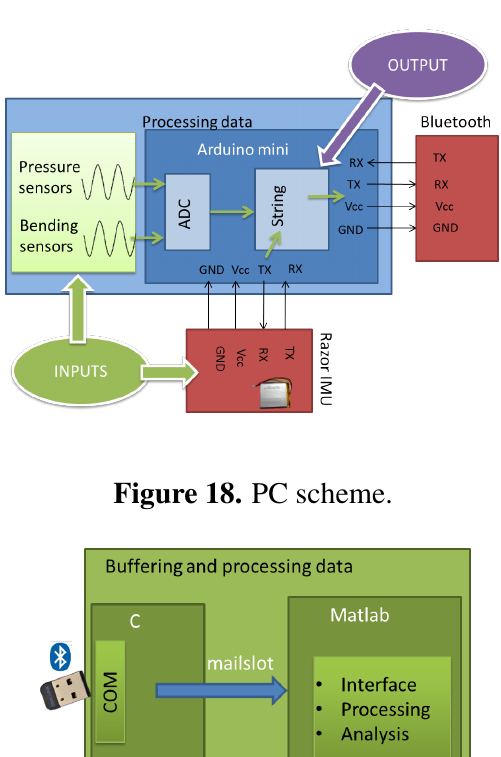
Figure 17. Arduino functions scheme.